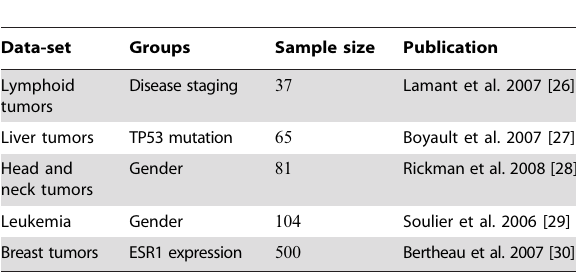
Table 1. Data sets used for the gene list analysis.